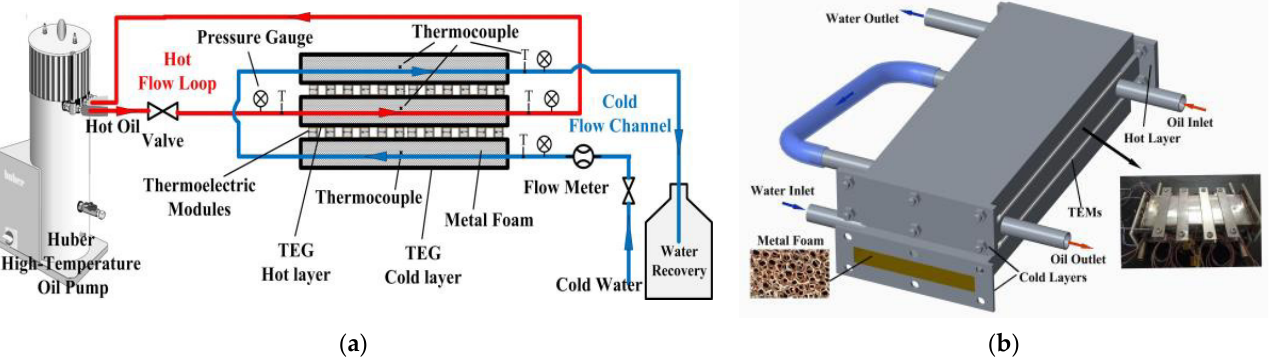
Figure 24. Schematic of the TEG system consisting out of channels filled with metal foam: ( a ) Experimental setup; ( b ) Prototype. Reprint with permission [98]; Copyright 2021, Elsevier.